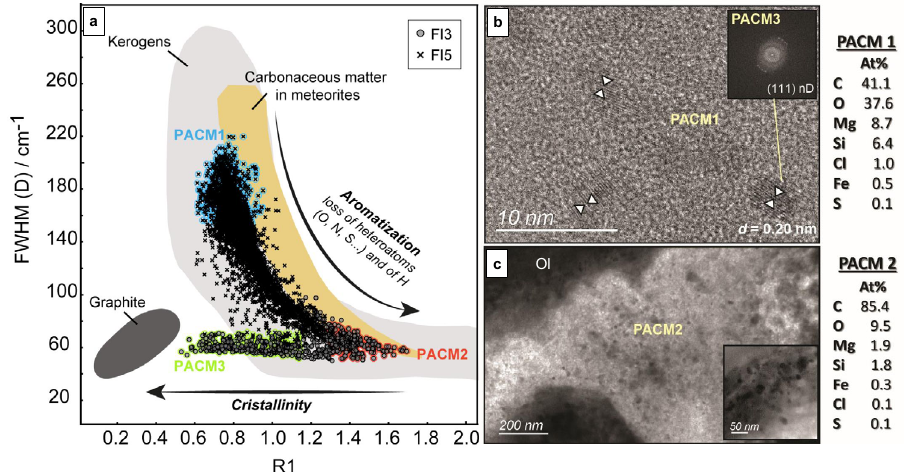
Fig. 4 | Diversity of the polyaromatic carbonaceous material that displays strong structural and chemical heterogeneities while coexisting at micro- metric scale in the two individual fl uid inclusions (FI3 and FI5). a PACMs het- erogeneity as shown by fi tting parameters derived from 3D hyperspectral Raman mappingofFI3andFI5(e.g.Fig.3a),namelyfullwidthathalfmaximum(FWHM)of the D (i.e., disorder) band and the relative intensities R 1 of the D and G (i.e., gra- phite) bands (= I D / I G ). The colored data correspond to the data points used to calculate mean Raman signals shown in Fig. 3b. Also reported are the values obtained for kerogens, carbonaceous material in meteorites, and graphite com- piled from the literature 33 – 35 . b , c High resolution TEM imaging of the PACMs with the qualitative chemical composition of PACM1 and PACM2 measured with energy